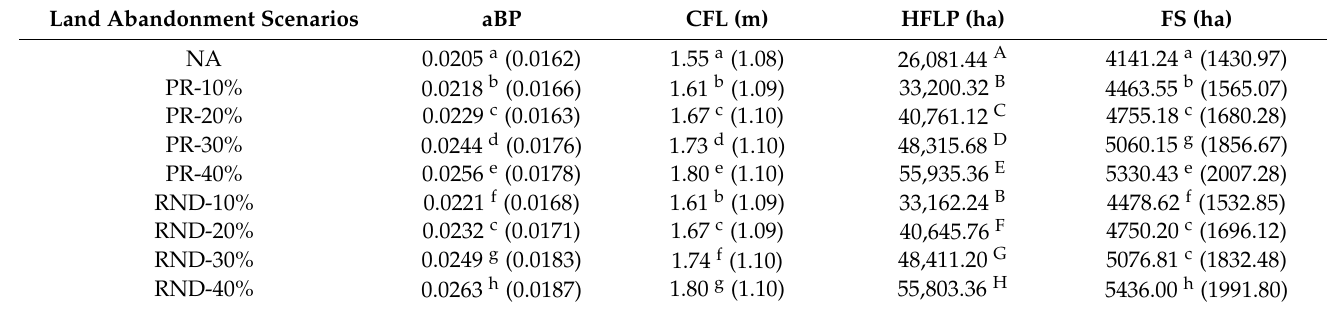
Different letters in the same column indicate significant differences at p < 0.05.